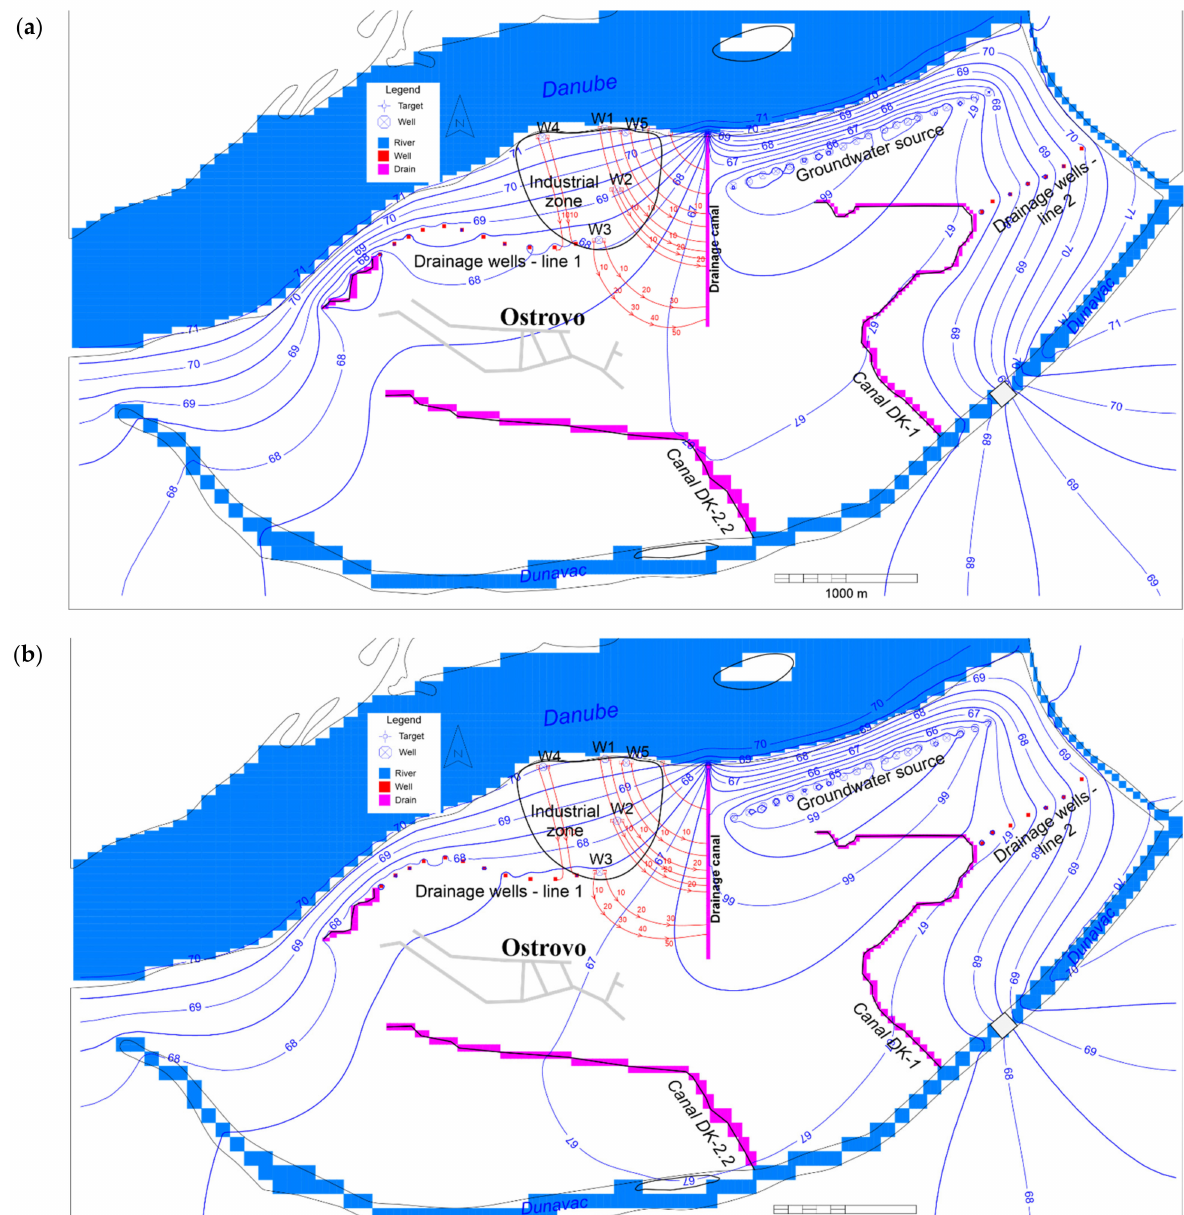
Figure 18. Flow pattern of Plan 3 (drainage canal) at the ( a ) high and ( b ) low stages of the Danube recorded in 2015 (second model